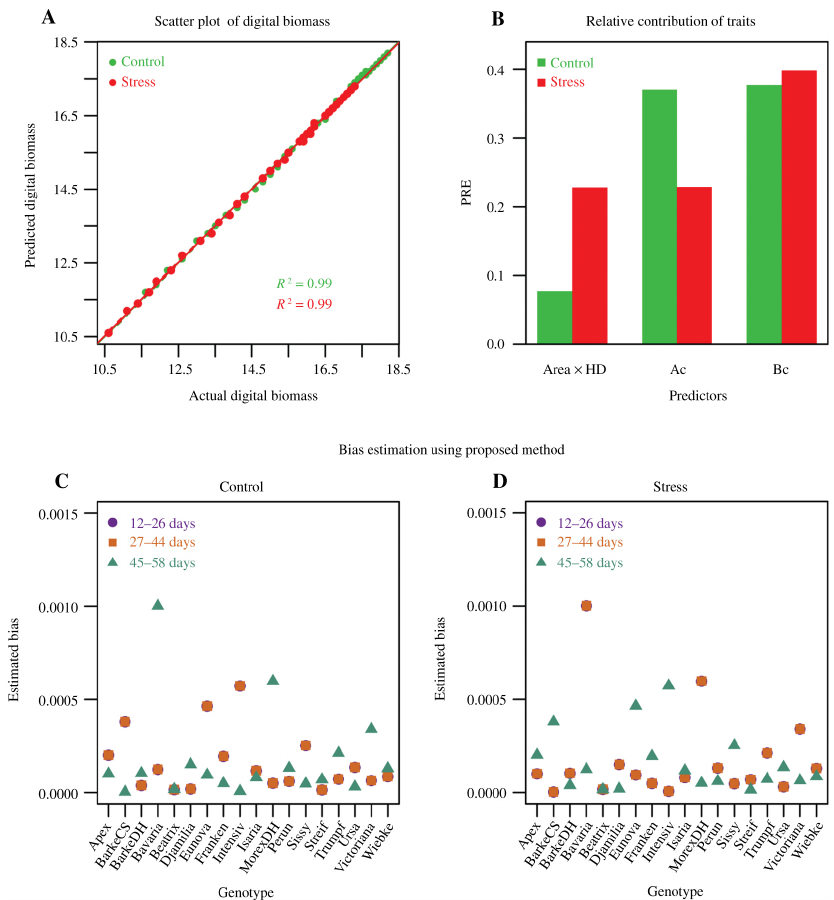
Figure 3: Models accuracy and the relative contribution of traits. (A) Scatter plot of image-derived actual biomass com- pared with the estimated values using the proposed model for the controlled and stressed plants, (B) the relative contri- bution of model predictors (traits) area × days and compactness for the image derived biomass model used in this study, (C,D) bias estimation using the proposed model in different barley cultivars under different water condition of two treat-